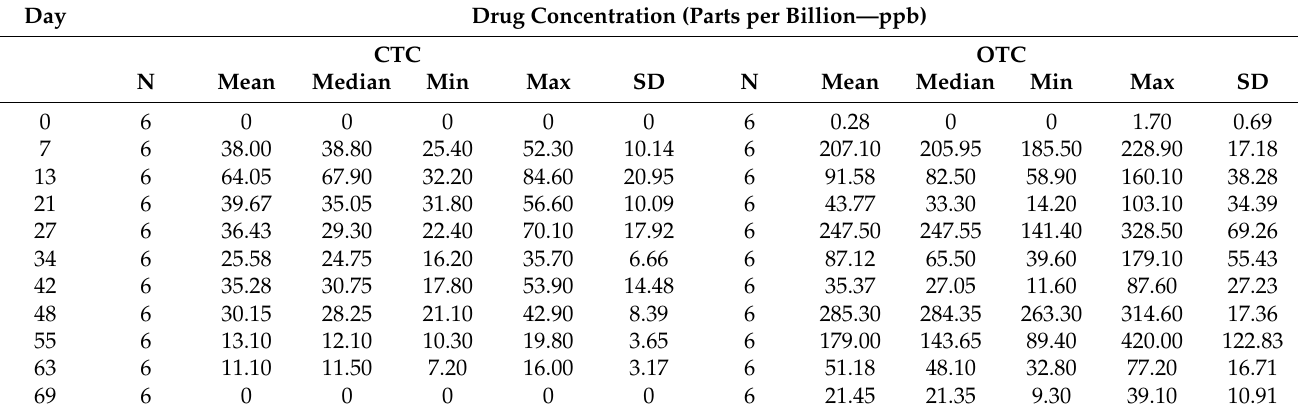
Table 2. Summary of steer plasma drug concentration levels by study day and treatment